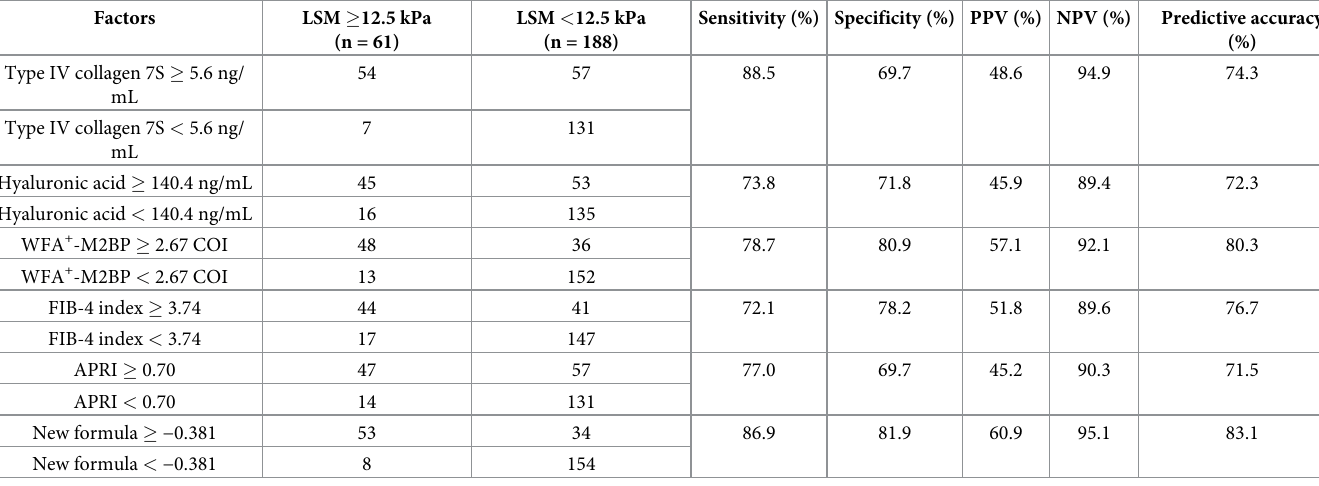
Table 4. Diagnostic performance of fibrosis markers and formulae for predicting LSM � 12.5 kPa (liver cirrhosis) in the validation set.